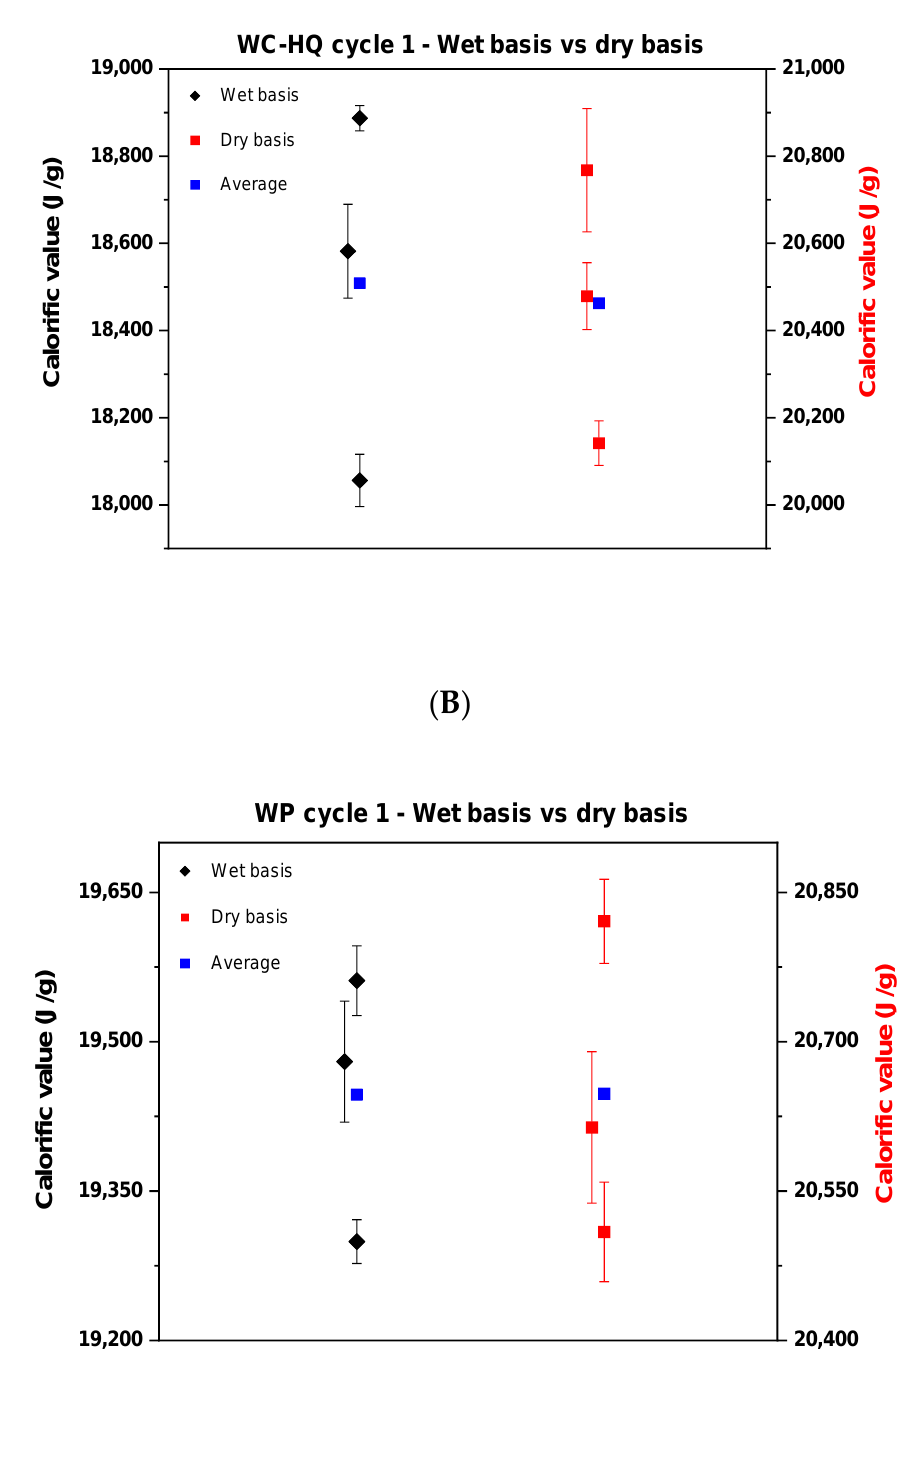
Figure 1. Comparison of the calorific values between the wet basis and dry basis in cycle 1. ( A ) describes the wood chips—industrial quality, ( B ) the wood chips—high quality, ( C ) the wood pellets. Each point in Figure 1 represents the average of the results of each institute. Wide scattering is visible in all samples where the reproducibility difference on a wet basis was 800, 800 and 300 J for wood chips of industrial quality, wood chips of high quality and